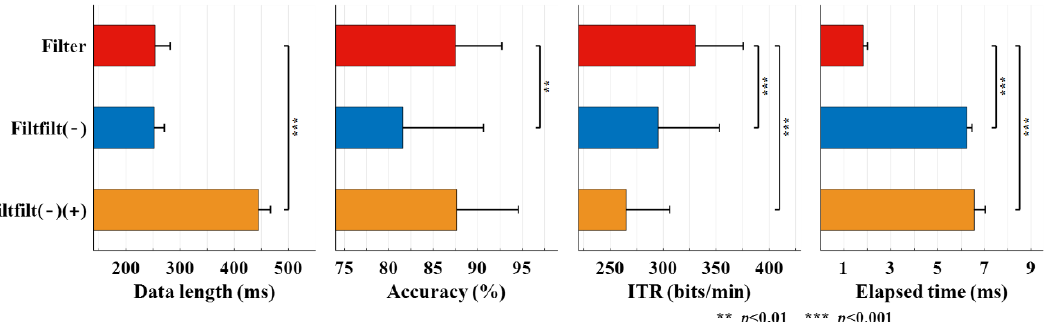
Figure 9. The data length, accuracies, ITRs and elapsed time under the three filtering strategies. The